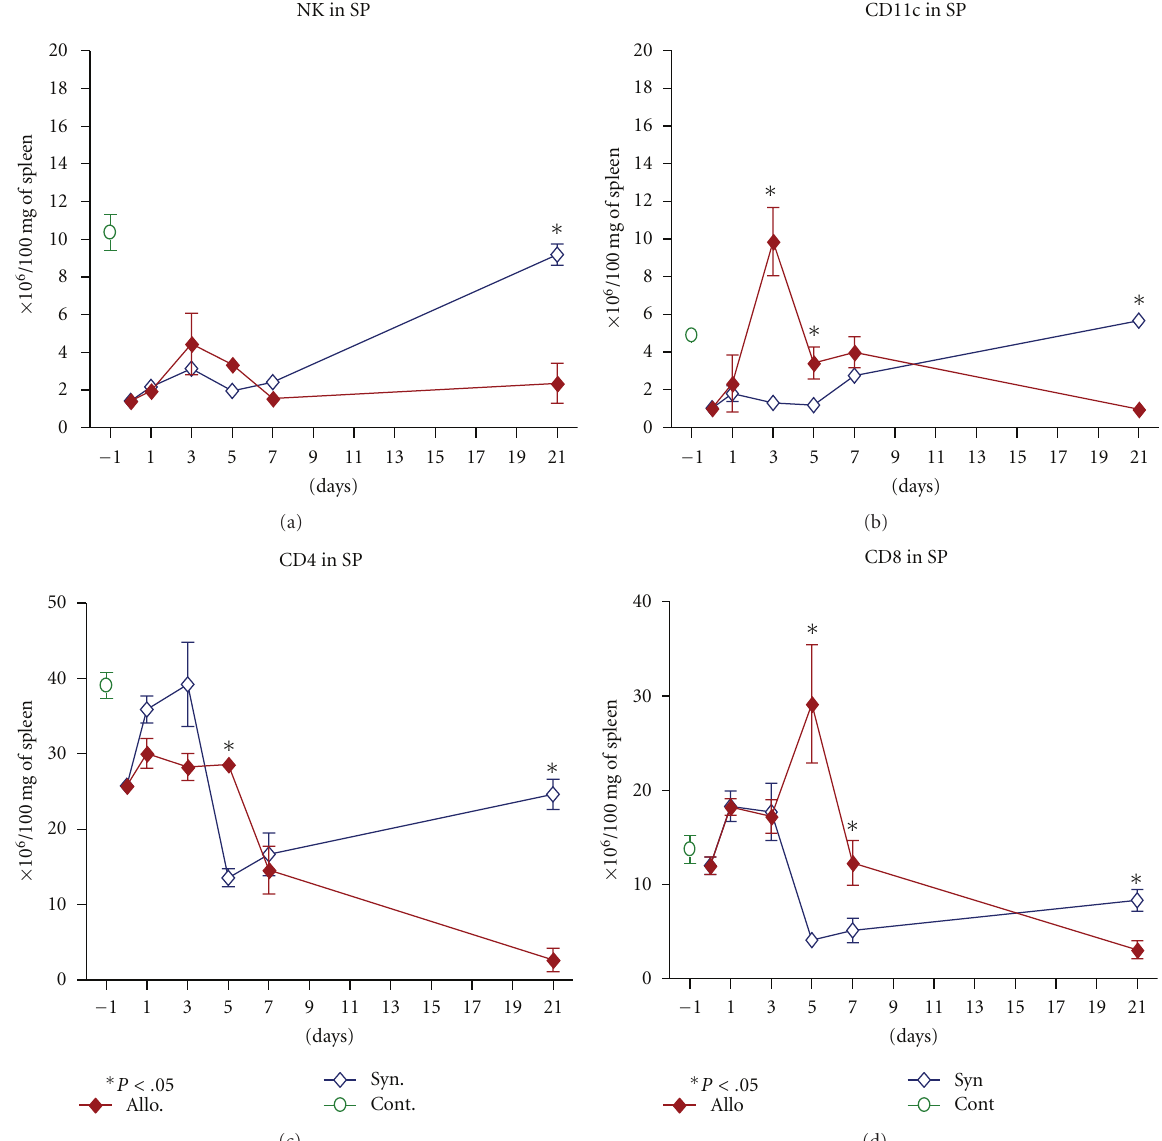
Figure 2: Immune cell phenotype and repopulation pattern in the spleen of allogeneic and syngeneic transplanted mice at the early phase of GVHD. Female BALB/c mice were transplanted with 20 × 10 6 and 30 × 10 6 BM and SP cells, respectively, from male C57BL/6 (allogeneic) or BALB/c (syngeneic) mice. Repopulations of di ff erent immune cells were evaluated in the spleen of recipient mice. Absolute number of (a) NK (DX5) (b) DCs (CD11c) (c) CD4 T helper and (d) CD8 cytotoxic T cells in 100 mg of the spleen tissue in allogeneic and syngeneic setting. ( (cid:2) ): allogeneic group, ( ♦ ): syngeneic group and (O): control mice. All values are mean ± SE for 4 to 6 animals in each group